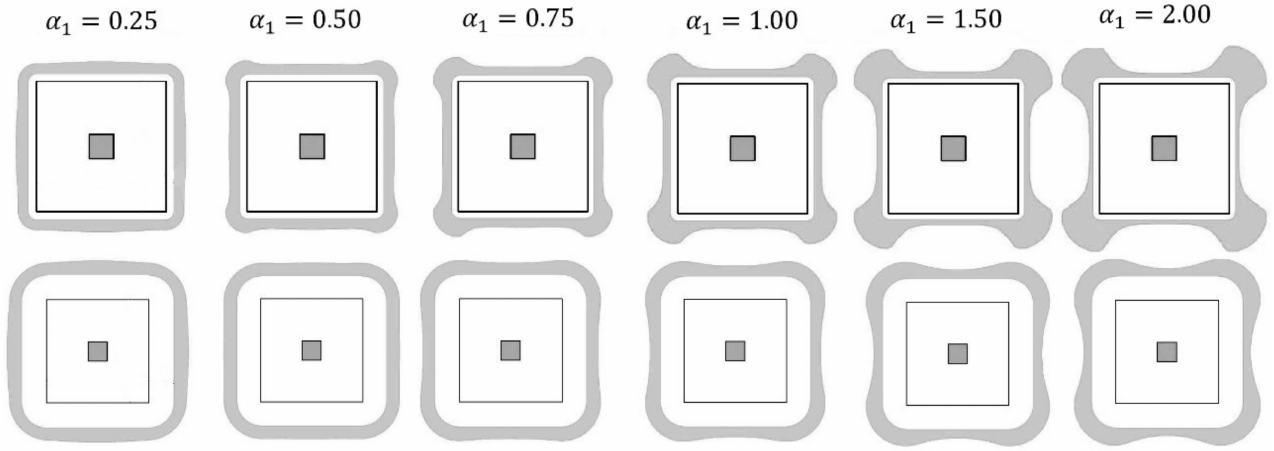
Figure A3. Graphs of the shear forces in the control perimeter depending on the shear cap height—160 cm shear cap width (c/d =